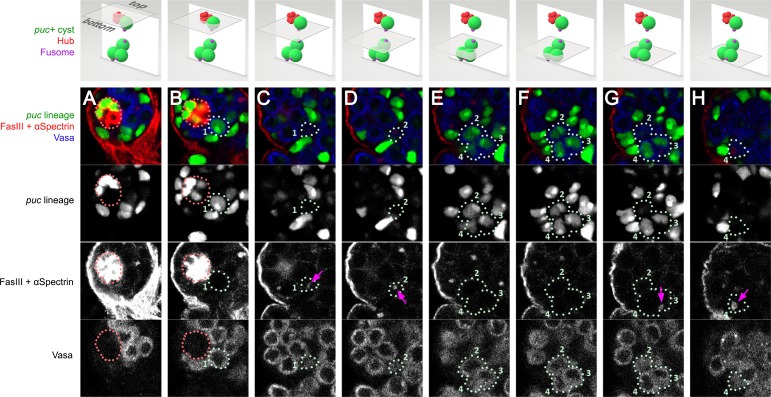
Example of fragmentation of 4-cell spermatogonia that experienced JNK activation.Different planes of a 20 μm z-stack of a testis from a puc > GFP male after 15 days of starvation and 3 days of refeeding. Each plane is 1.0 μm thick. The cells of the fragmenting germ cyst are labeled 1–4 with ‘1’ being the cell at the niche (the presumed GSC) and ‘2’, ‘3’ and ‘4’ being the remaining cells that are not at the niche. The first row of the figure is a 3D model generated in Paint3D to illustrate the position of the plane in the z-stack as well as the position of the fragmenting germ cyst in the stack. (A–H) The puc-lineage is marked in green; FasIII, which marks the niche, and αSpectrin, which marks spectrosomes/fusomes, are labeled in red; Vasa, which labels the germline, is in blue. (B) shows the puc > GFP labeled GSC (cell ‘1’) at the niche. (C) shows the dot fusome (arrow) of cell ‘1’. (D–H) show the remaining three puc > GFP germ cells of the fragmented 4-cell spermatogonia (labeled ‘2’, ‘3’ and ‘4’). The dot fusome of cell ‘2’ is shown in (D, arrow). The dot fusome of cell ‘3’ is shown in (G, arrow). The dot fusome of cell ‘4’ is shown in (H, arrow).